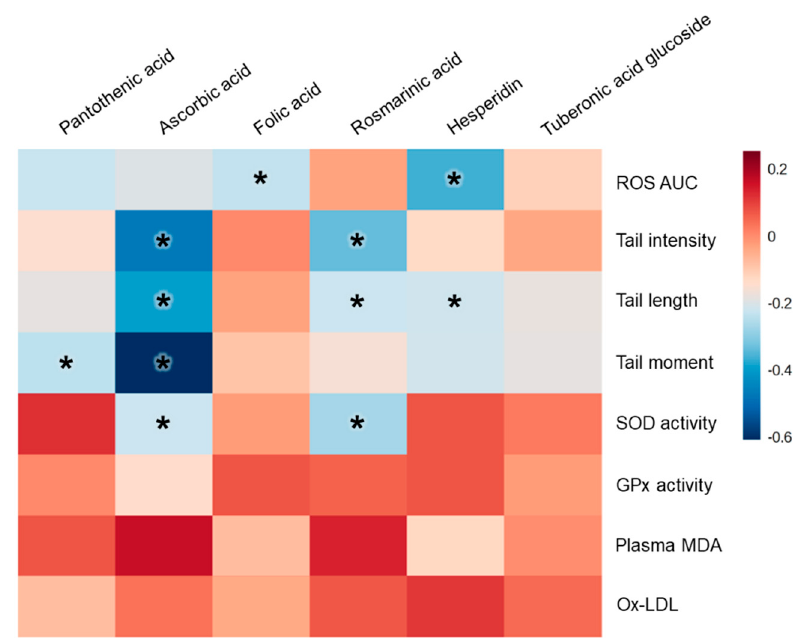
Figure 6. Heat map illustrating Pearson correlation coefficients between plasma and erythrocyte biomarkers and plasma vitamin and phytonutrients. Reactive oxygen species (ROS); area under the curve (AUC); superoxide dismutase (SOD); glutathione peroxidase (GPx); malondialdehyde (MDA); oxidized low-density lipoprotein (Ox-LDL). * P < 0.05. Table 3. Correlation between biomarkers and plasma vitamins and phytonutrients 1 .